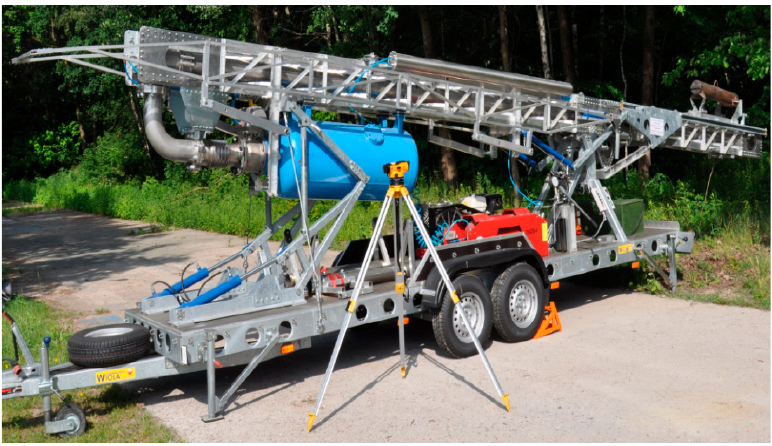
Figure 1. General view of the pneumatic launch tube.